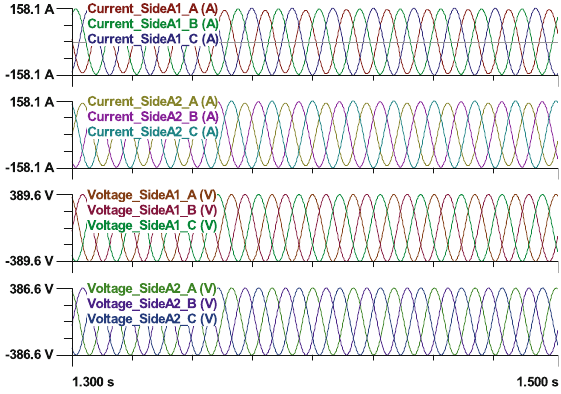
Fig. 8 Three phase currents and voltages of event 2: internal high impedance fault, grid-connected mode